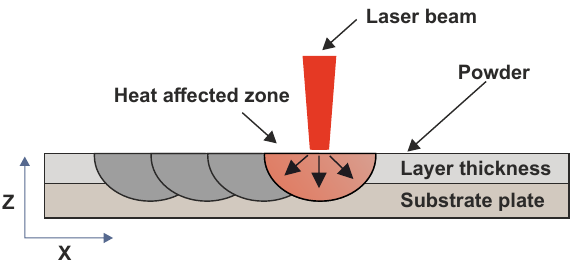
Figure 2. Heat affected zone during melting.